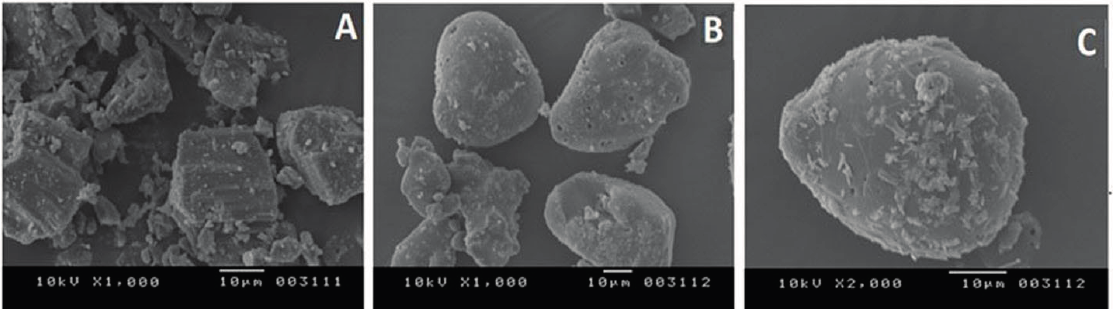
Figure 3. XRD spectra of CMN and MSC CMN.